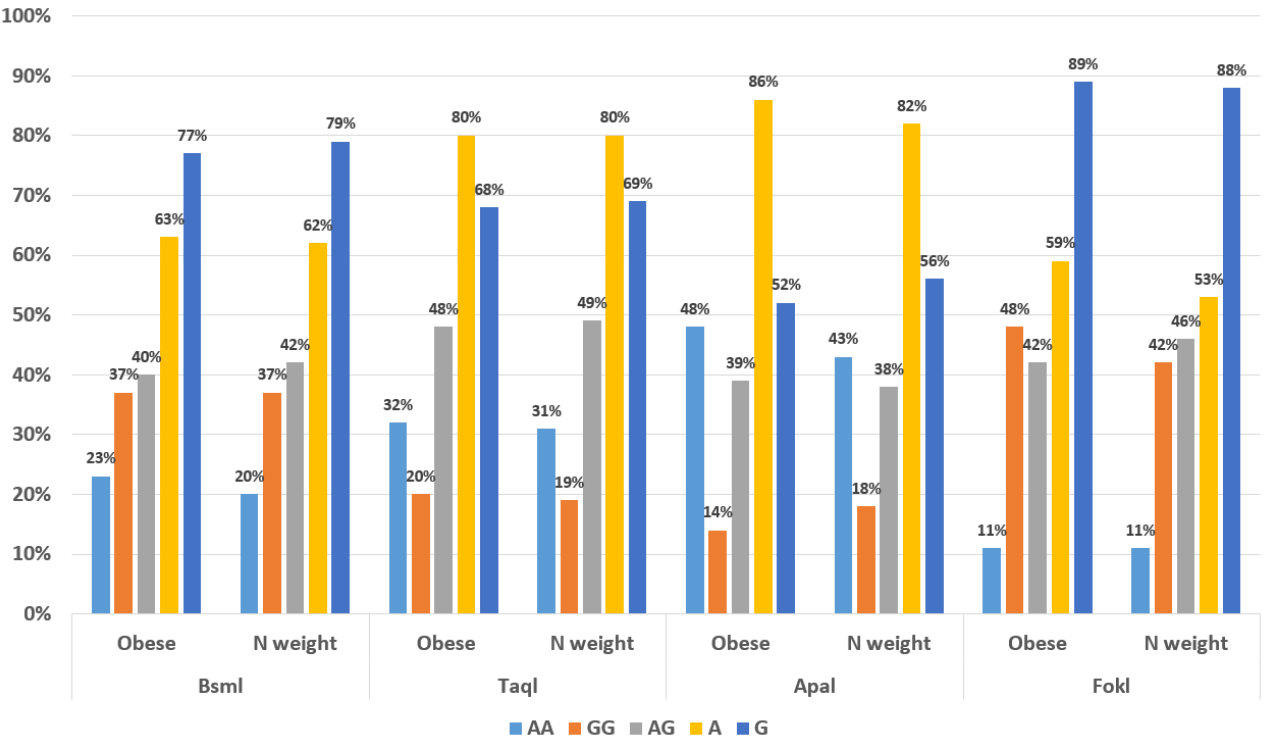
Figure 4. Genotypes and allele percentage distribution of four VDR gene polymorphisms in obese subjects compared to normal weight (N weight) subjects.